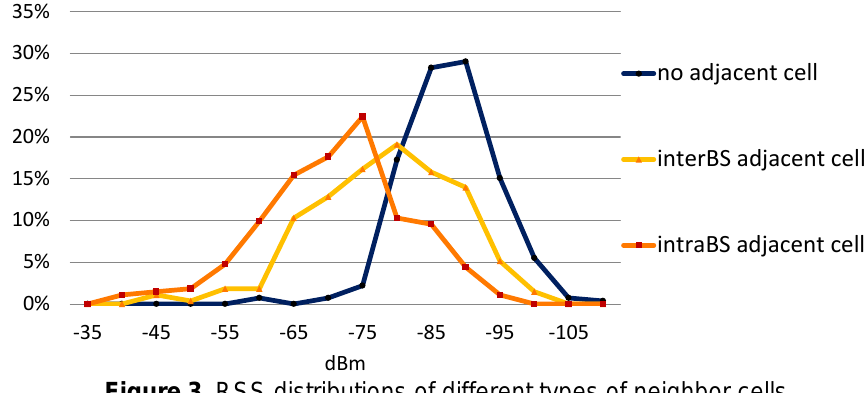
Figure 3. RSS distributions of different types of neighbor cells